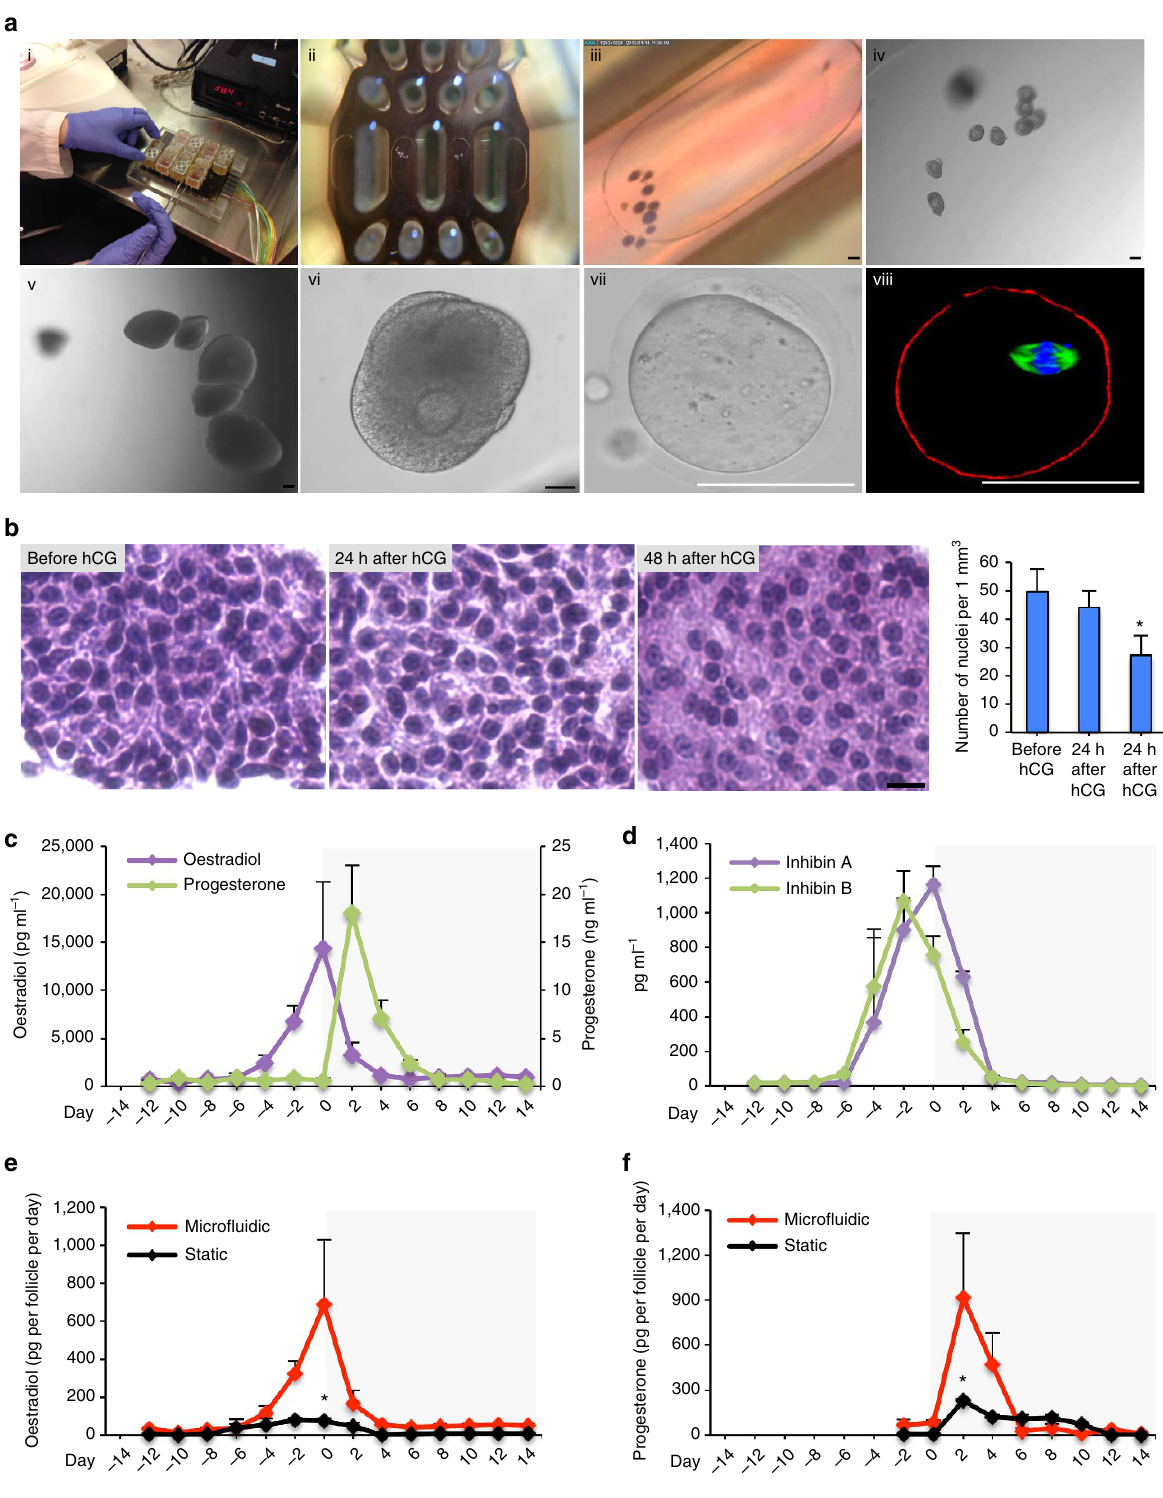
Figure 3 | Microfluidic platform supported follicle maturation and hormone secretion in the Solo-MFP. ( a ) Multiple follicle culture in the Solo-MFP (stages i–iii); microfluidic culture supported follicle growth from primary stage to antral stage (iv–vi); and, following hCG stimulation, completion of the first meiotic division by the oocyte was achieved oocyte completed the first meiosis indicated by well-organized microtubule fibres (green), tightly aligned chromosomes (blue), and the round appearance of F-actin (red; stages vii–viii). ( b ) Granulosa cells showed similar morphological changes as seen in vivo following luteinization, indicated by hypertrophy and decreased nucleus to cytoplasm ratio. ( c , d ) Ovarian hormone secretions of oestradiol (E2) and progesterone (P4; c ) and inhibin A and inhibin B ( d ) over 28 days of culture in the Solo-MFP. ( e , f ) Comparison of E2 ( e ) and P4 ( f ) secretion rates between microfluidic and static cultures. Graphs in b , f display average þ s.d. * P o 0.05 comparison of the number of nuclei per mm 3 in follicles before and after hCG treatment ( b ), and hormone secretion rates between microfluidic and static cultures ( e , f ). Scale bar, 50 m m ( a ) and 10 m m ( b ). n ¼ 3–6 replicates for both the microfluidic and static